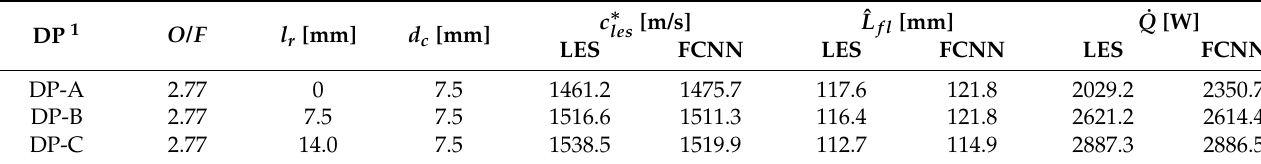
Table 6. Design points inspected during the recessed injector analysis. The values of the LES and MLPs’ prediction global quantities presented in Figure 5b,d,f are provided for completeness.